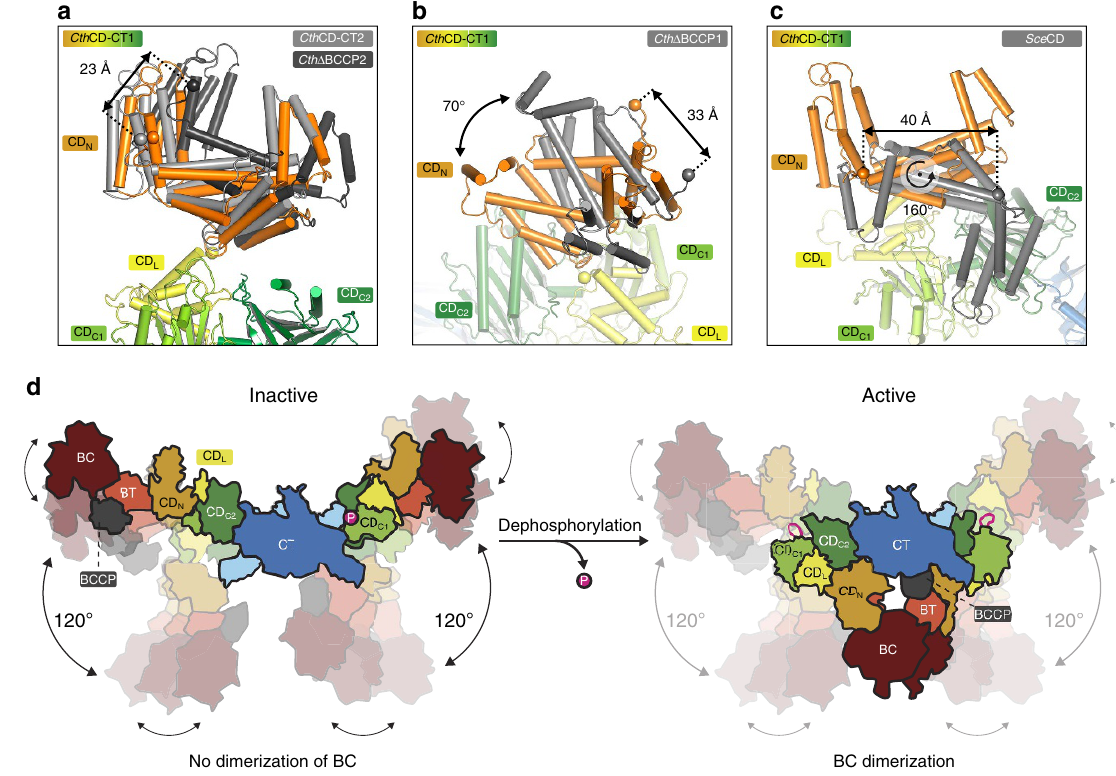
Figure 4 | The conformational dynamics of fungal ACC. ( a – c ) Large-scale conformational variability of the CD N domain relative to the CD L /CD C1 domain. Cth CD-CT1 (in colour) serves as reference, the compared structures (as indicated, numbers after construct name differentiate between individual protomers) are shown in grey. Domains other than CD N and CD L /CD C1 are omitted for clarity. The domains are labelled and the distances between the N termini of CD N (spheres) in the compared structures are indicated. ( d ) Schematic model of fungal ACC showing the intrinsic, regulated flexibility of CD in the phosphorylated inhibited or the non-phosphorylated activated state. Flexibility of the CD C2 /CT and CD N /CD L hinges is illustrated by arrows. The Ser1157 phosphorylation site and the regulatory loop are schematically indicated in